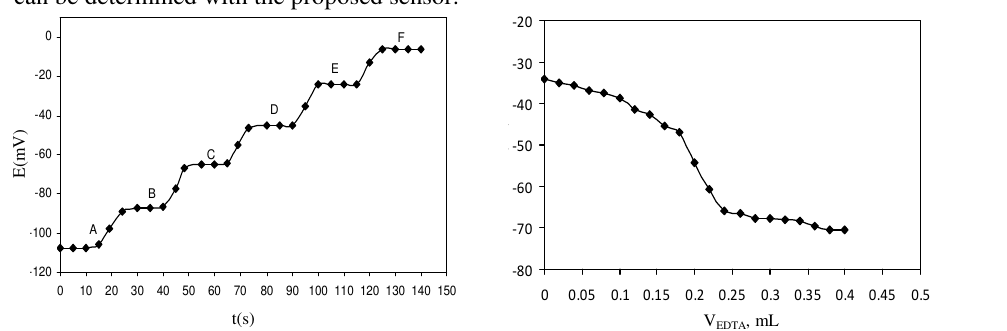
Figure 5. Potential titration curve of 20.0 mL from a 1.0 × 10 -4 M Gd 3+ solution